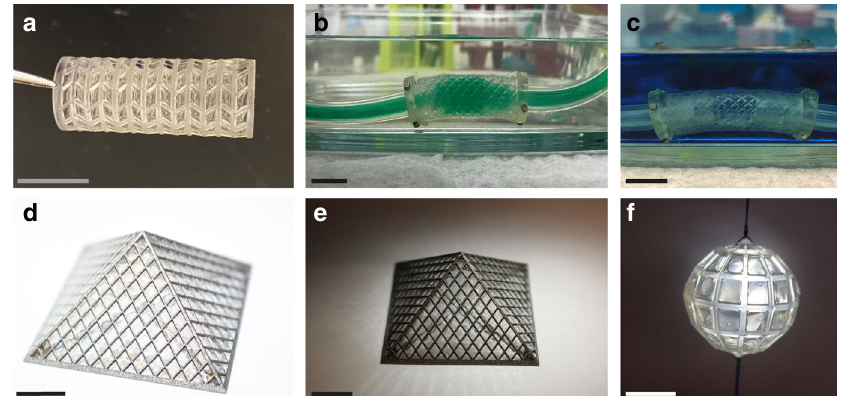
Fig. 4 Material versatility and geometric control. a Tubular mesh structure coated with 2 mg mL − 1 collagen gel following 1 h gelation at 37 °C. Tubular meshes coated with 7.5 wt% methacrylated gelatin hydrogel formed a complete seal that held b liquid and c air pressure. d , e Louvre-like pyramids printed in stainless steel coated with neat thiol-ene networks via photopolymerization ( λ = 365 nm; I 0 = 6 mWcm − 2 ; t = 30 s). f . Polyhedron coated with 7.5 wt% methacrylated gelatin. Scale bars,